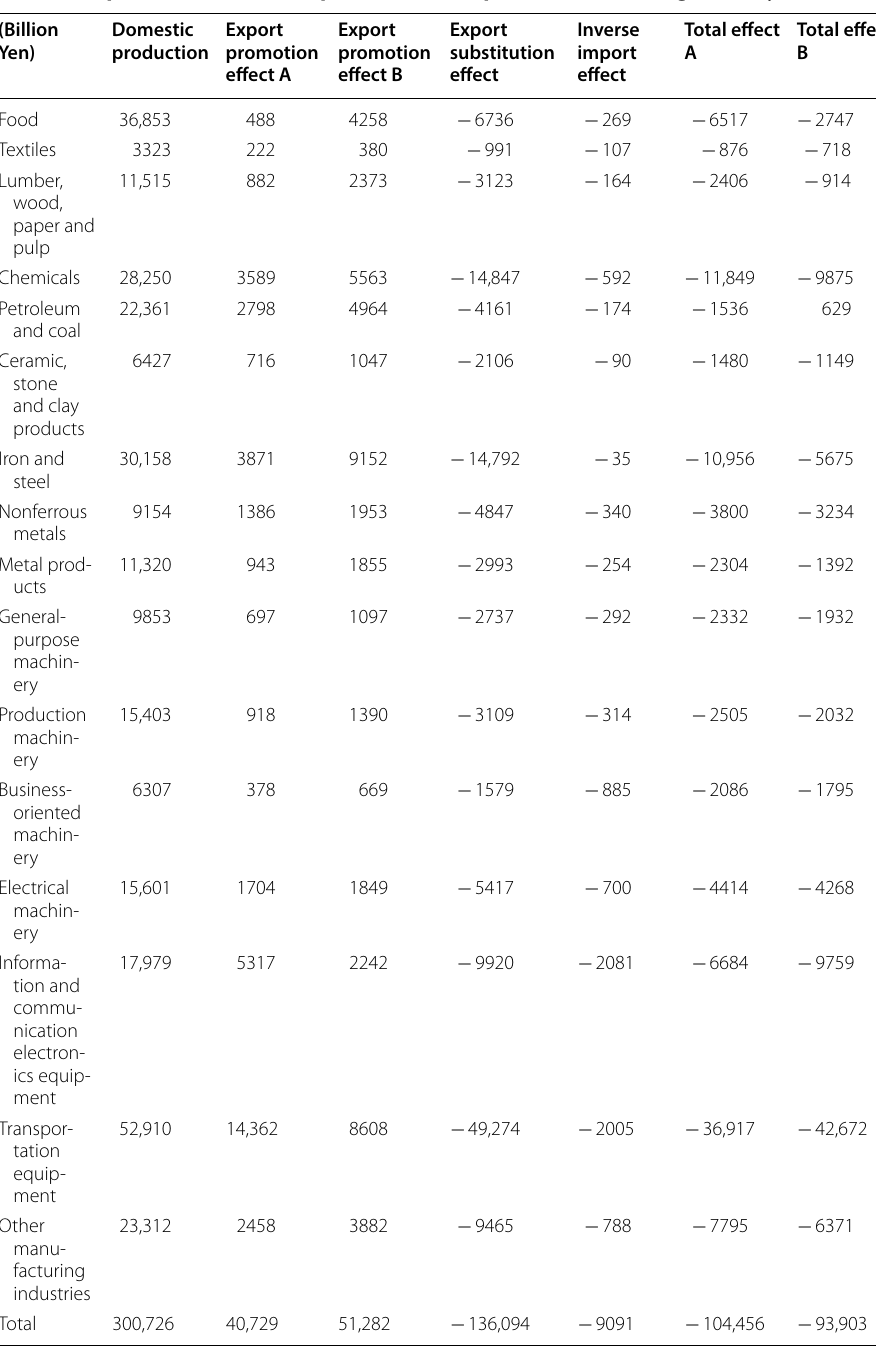
Table 1 Impact on the domestic production of Japan’s manufacturing industry in